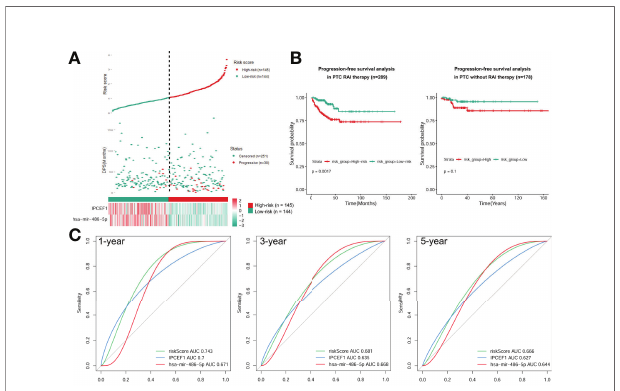
FIGURE 7 | Construction of a prognostic risk model. (A) Risk score based on the 2 signatures, survival status, and heatmap for the expressions of them for each RAI therapy PTC patient. (B) PFS difference between high-risk and low-risk groups of PTC with RAI therapy or without RAI therapy using the Kaplan – Meier curve. (C) Time-dependent ROC curves of the risk score were adopted to estimate the predictability of PFS at 1, 3, and 5